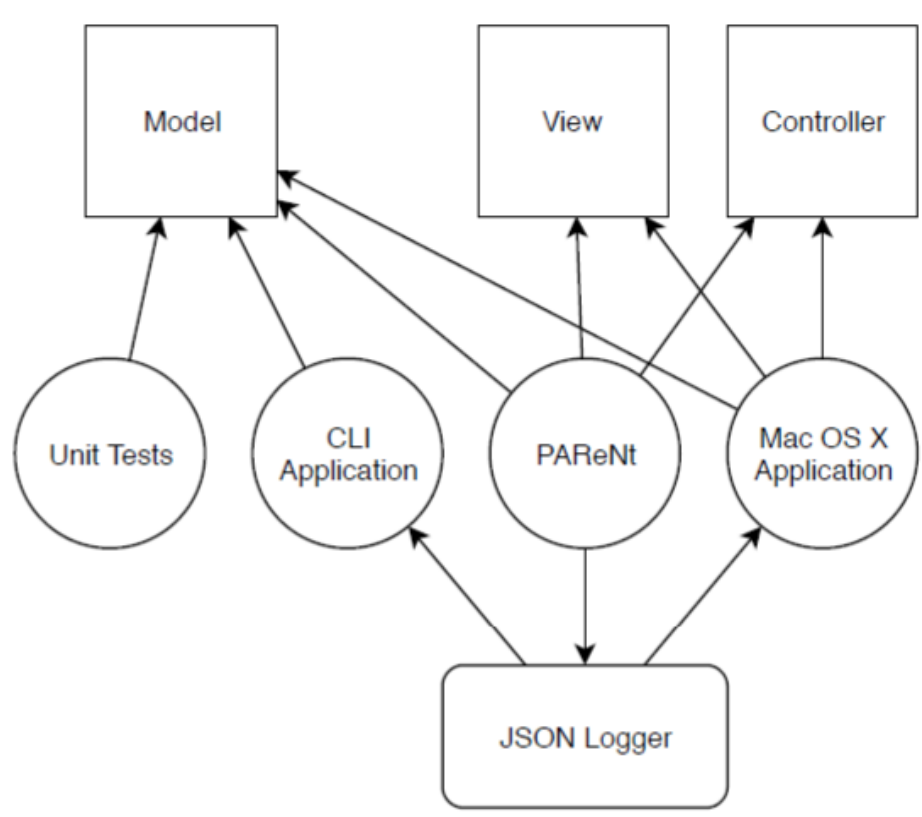
Figure 4. Overview of the